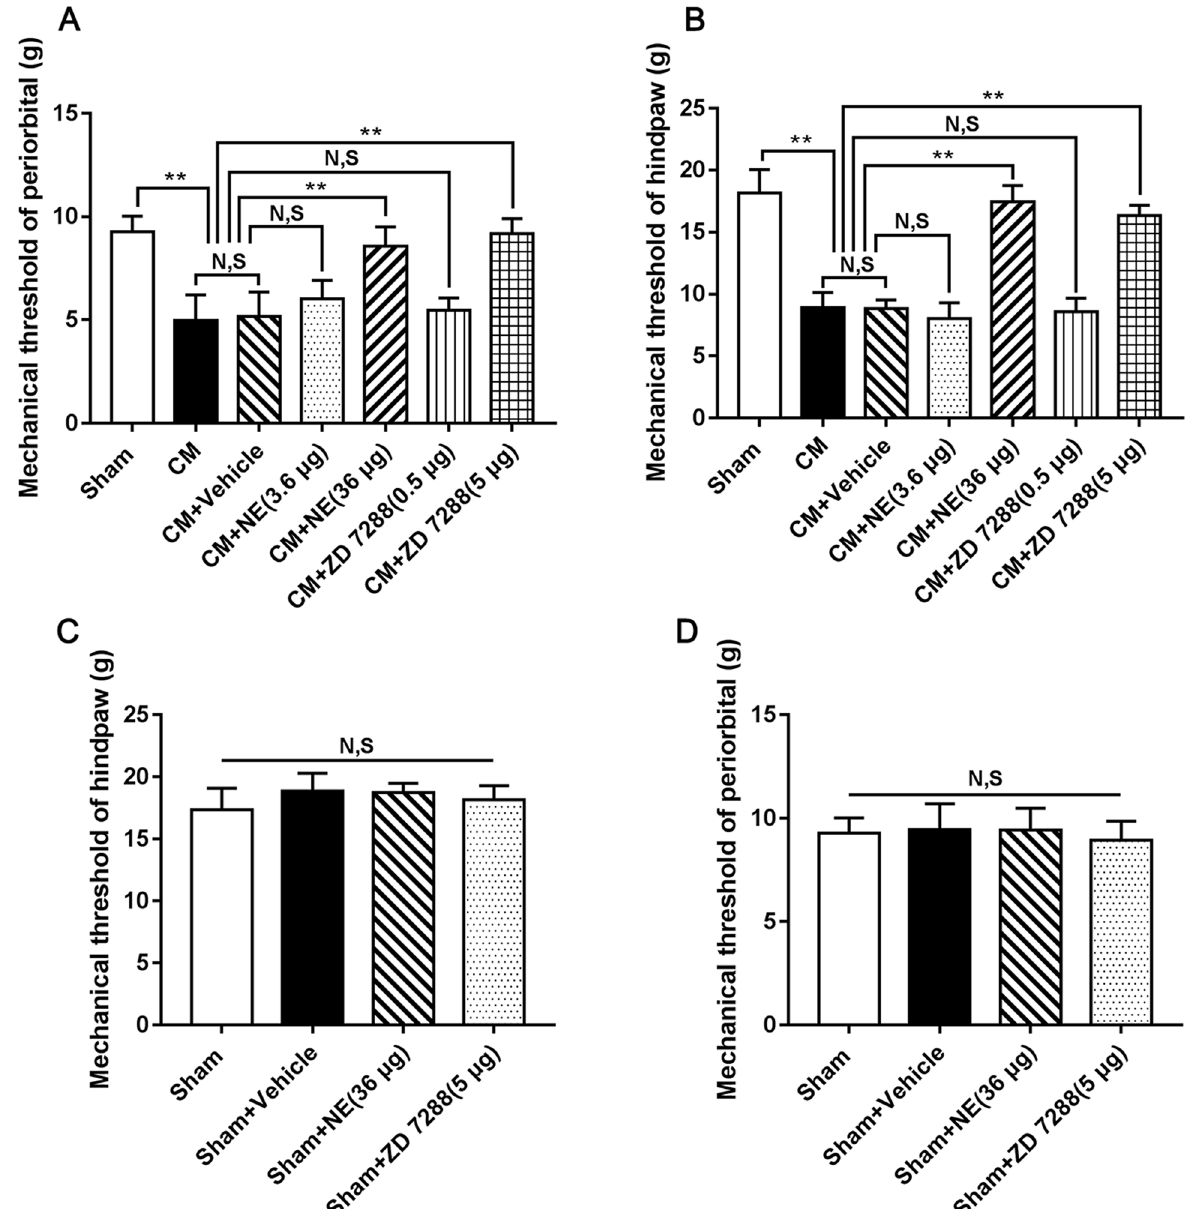
Fig. 4 The effect of NE and ZD 7288 on hyperalgesia in CM rats. A and B The mechanical pain thresholds of the periorbital region and hindpaw in the CM group were substantially lower than those in the Sham group, and there was no obvious difference between the CM and CM Vehicle + groups. Compared to the CM Vehicle group, the mechanical pain thresholds of the periorbital region and hindpaw in the CM NE (36 μg) and + + CM ZD 7288 (5 μg) groups were both profoundly elevated. The mechanical pain thresholds of the periorbital region and hindpaw did not show + substantial differences among the CM Vehicle, CM NE (3.6 μg), and CM ZD 7288 (0.5 μg) groups. ( n 6/group, ** p < 0.01, N, S, not significant). + + + = C and D . No substantial difference was found in the mechanical pain thresholds of the periorbital region and hindpaw among the Sham, Sham Vehicle, Sham NE (36 μg), and Sham ZD 7288 (5 μg) groups. ( n 6/group, N, S, not + + + =